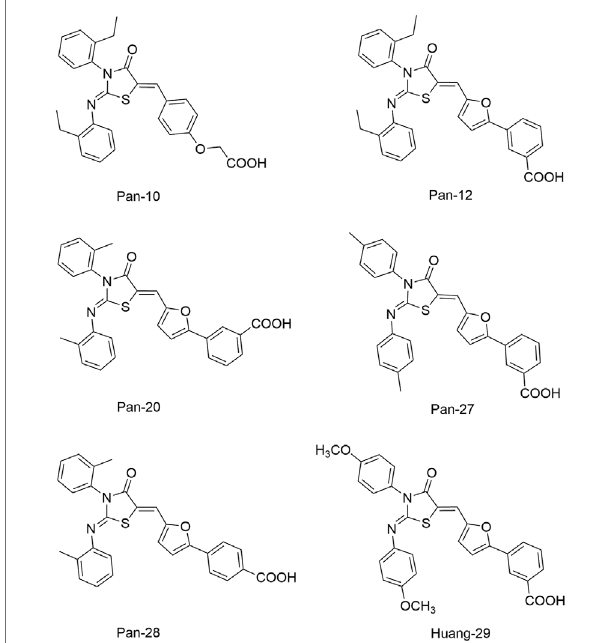
FIGURE 5 | The chemical structures of Pan-10, Pan-12, Pan-20, Pan-27, Pan-28, and Huang-29.